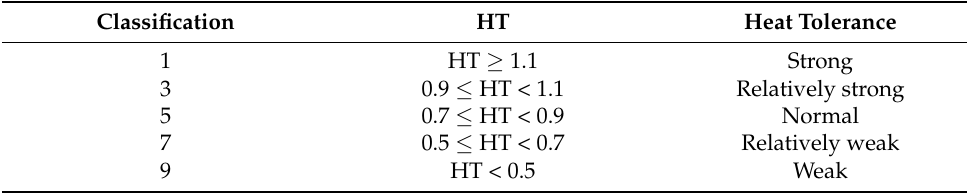
Table 2. Classification standard for heat tolerance of rice varieties.